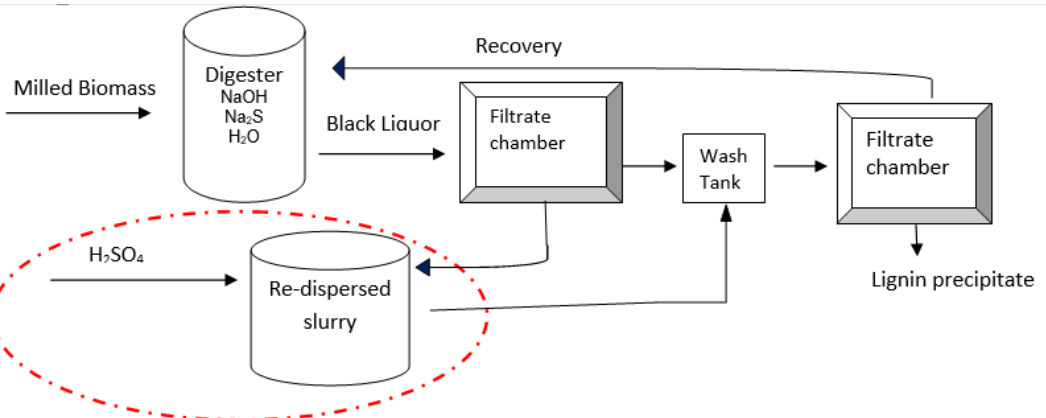
Figure 3. Simple layout of improved kraft pulping process (lignoboost).